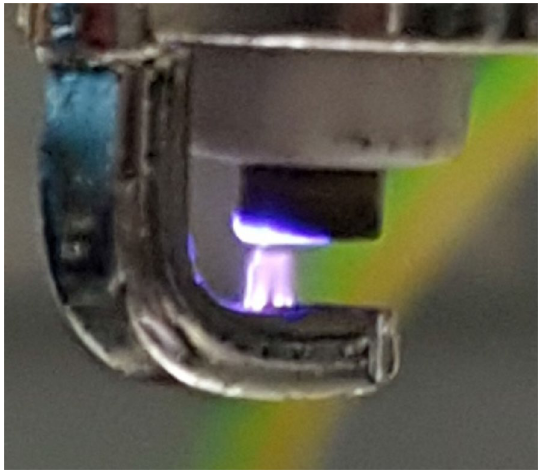
Fig. 12 Photograph of a typical ignition spark with an exposure time of 1/25 s. The picture shows the distribution of the discharge over the 2.5 mm wide cathode surface. At no time, the discharge covers the entire